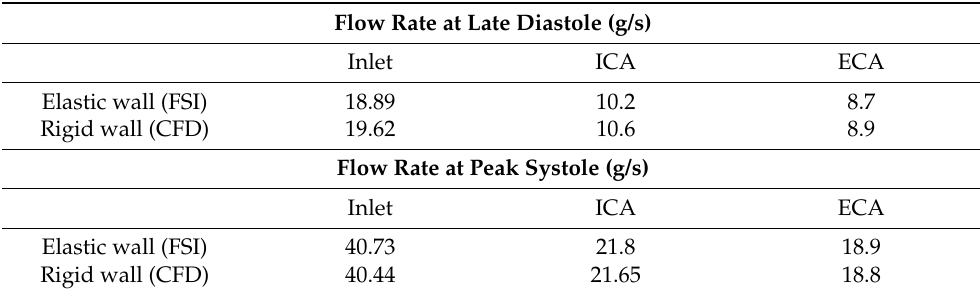
Table 6. Stenotic CCA (model C) mass flow rate distribution at the late diastole and peak systole of the cardiac cycle for elastic and rigid